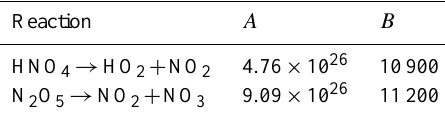
Table. C3. Unimolecular gas phase reactions and rate coefficients (from the RADM2 chemical mechanism, Stockwell et al., 1990) used in this work, that are calculated from equilibria. The rate coefficient is calculated as k(T ) = k r (T )Ae − B/T (DeMore et al., 1988), where k r (T ) is the rate coefficient of the corresponding formation reaction (Table C 2), and T the temperature in Kelvin. The units of A are cm − 3 , the units of B are Kelvin.